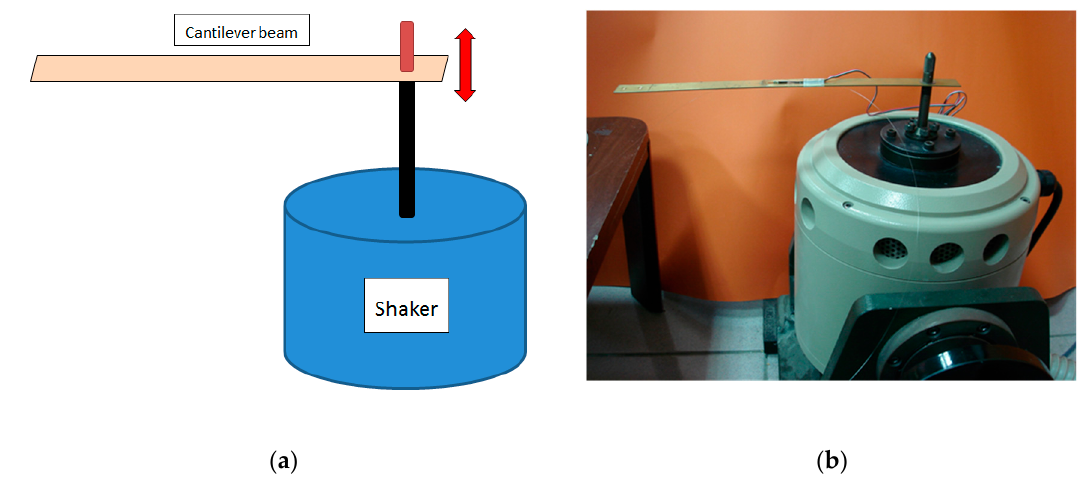
Figure 7. Base excitation test on a cantilever beam. ( a ) schematic diagram; ( b ) experimental setup.